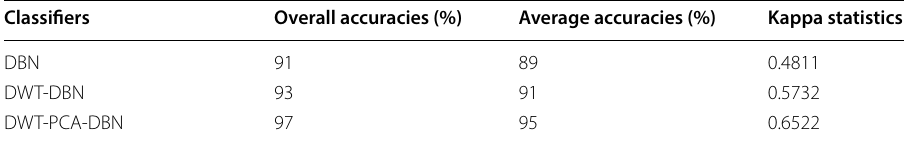
Table 4 Performance comparison based on overall accuracies, average accuracies, and Kappa statistics for DBN, DWT-DBN and proposed